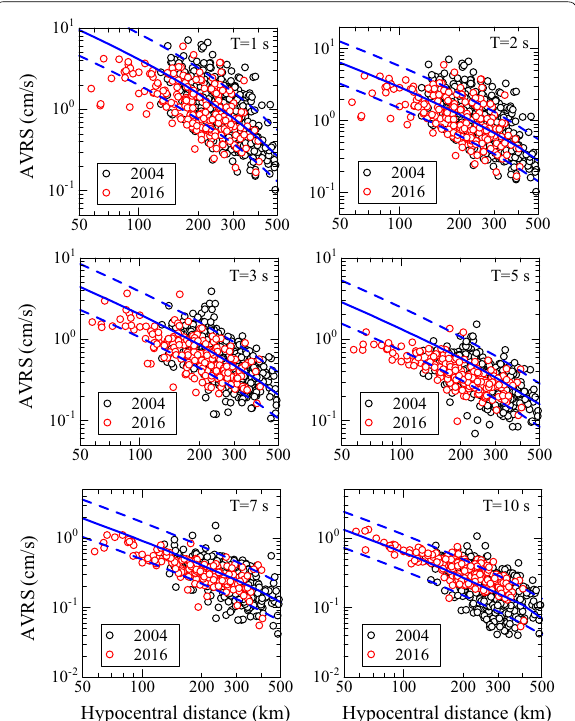
Fig. 11 Comparison of the observed absolute velocity response spectra (AVRS) for the 2004 (black circles) and 2016 (red circles) events at selected periods. The solid blue lines denote the median predictions using the GMPEs for AVRS (Dhakal et al. 2015) for Mj The dashed blue lines indicate a range of one standard deviation for the